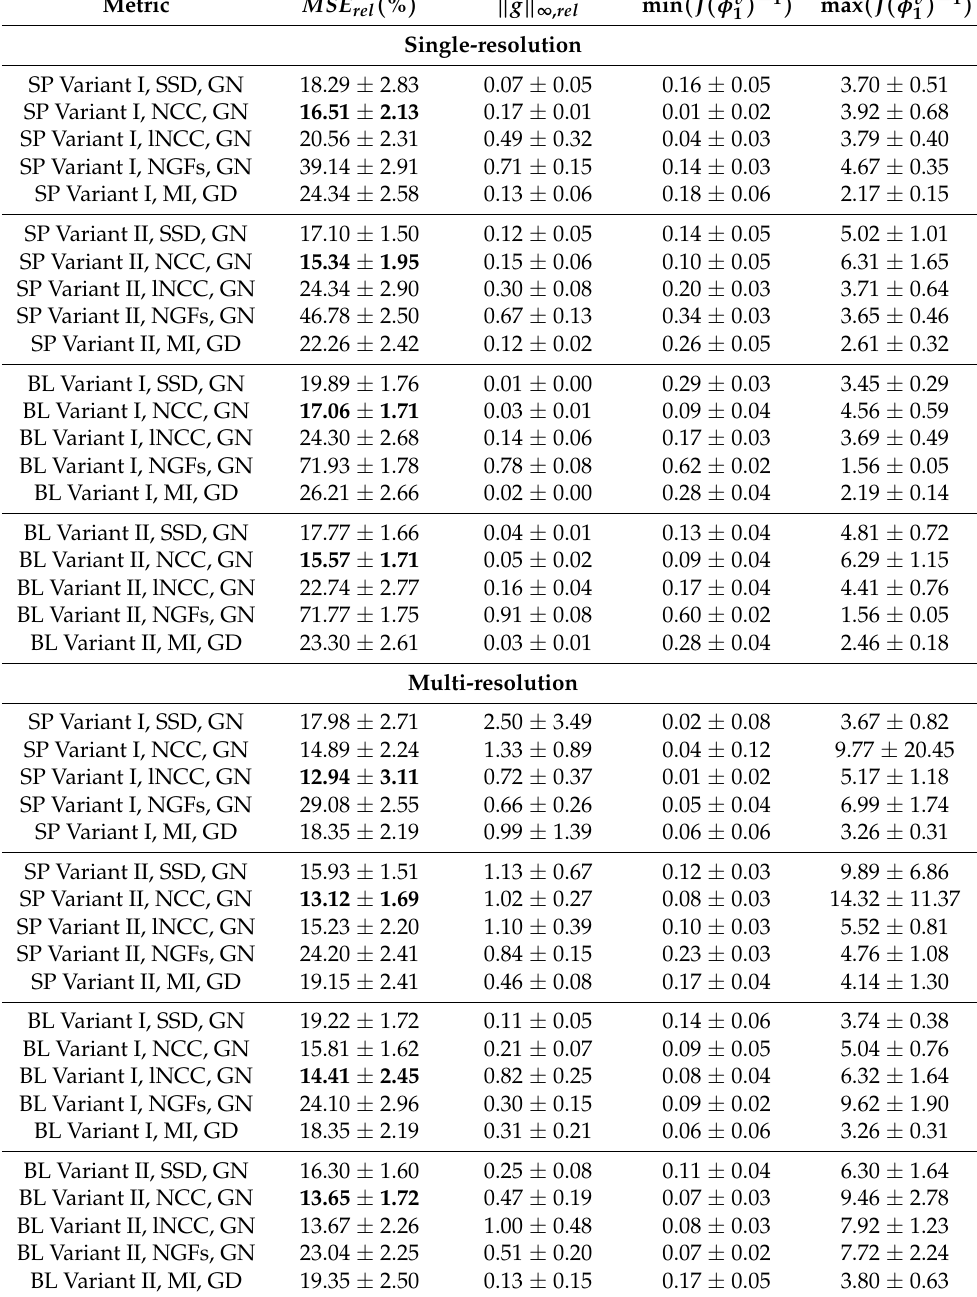
Table 2. NIREP16. Convergence results. Mean and standard deviation of the relative image similarity error expressed in % ( MSE rel ), the relative gradient magnitude ( nant extrema associated with the transformation ( φ v highlighted in bold